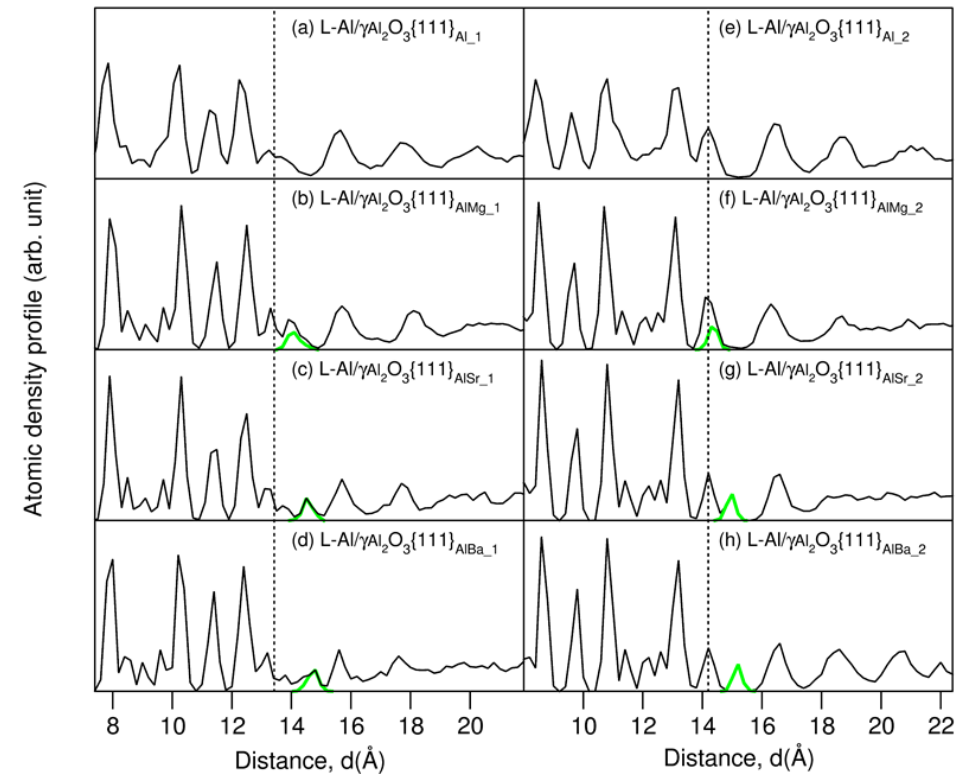
Figure 2. Atomic density profiles of the AE-segregated L-Al/ γ -Al 2 O 3 {1 1 1} AlAE interfaces and the parent L-Al/ γ -Al 2 O 3 {1 1 1} Al ( a , e ) [16]. The black curves represent the L-Al/ γ -Al 2 O 3 interfaces for all atoms, and the green for the AE atoms. The dotted lines represent the terminating Al atoms. Clearly, the distance between the AE atoms and the outmost O atoms is dependent on the atomic size of the